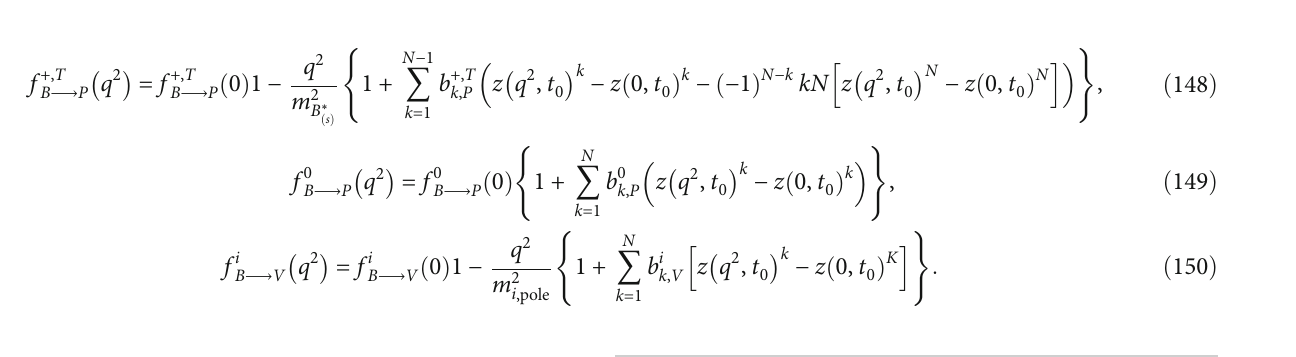
Figure 8: The q 2 dependence of the form factor f + line represents the total contribution. The black, blue, green, and yellow correspond to the LP contribution at LL, the LP contribution at NLL, the two-particle higher-twist correction, and the three-particle higher-twist correction,